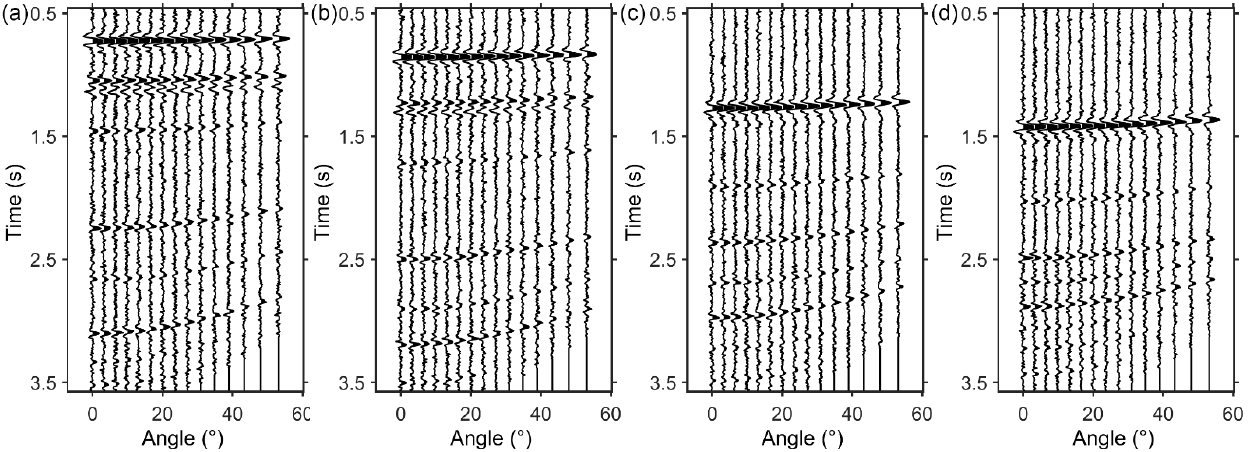
Figure 13. The noisy seismic angle gathers at ( a ) 1.25 km, ( b ) 2.25 km, ( c ) 3.25 km, and ( d ) 4.25 km of the model.